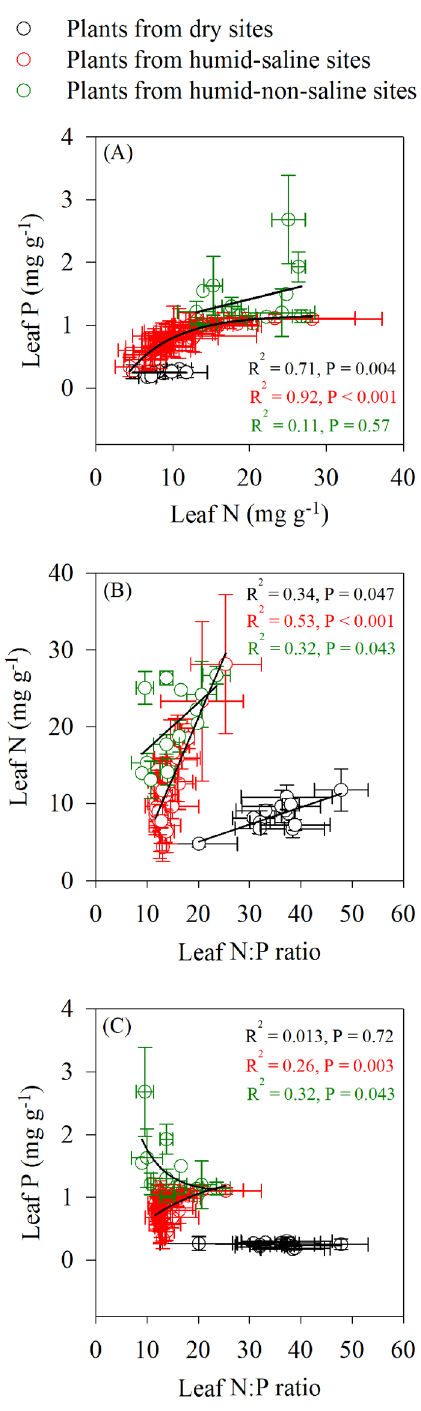
Figure 2. Relationships between leaf N or P concentrations and N:P ratios, respectively. The black, red and green circles represent the mean values of plant species’ N, P concentrations and N:P ratios from dry, humid- saline and humid-non-saline sites, respectively (error bars denote